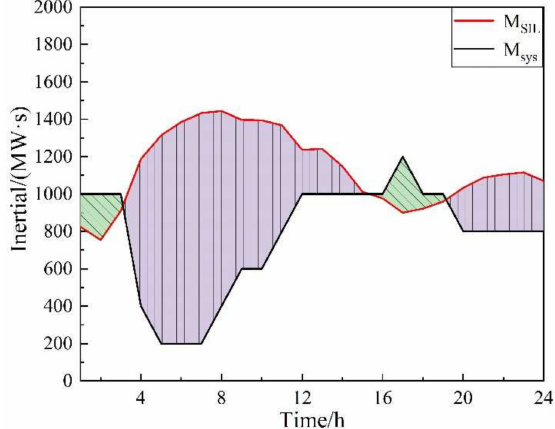
Figure 16. Typical daily inertia security region for scenario 2.